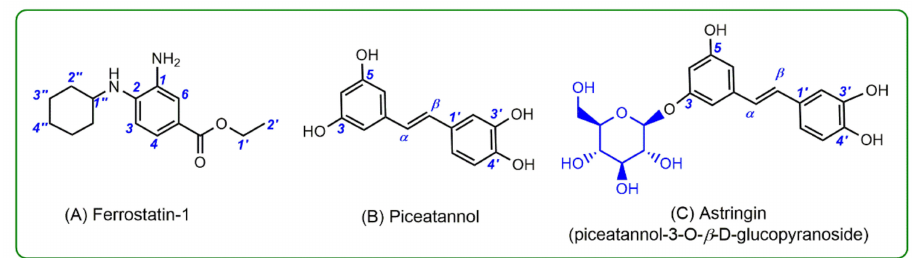
Figure 1. Structures of Ferrostatin-1 (Fer-1, A ), piceatannol ( B ), and astringin (piceatannol-3- O - β - D - glucopyranoside, C